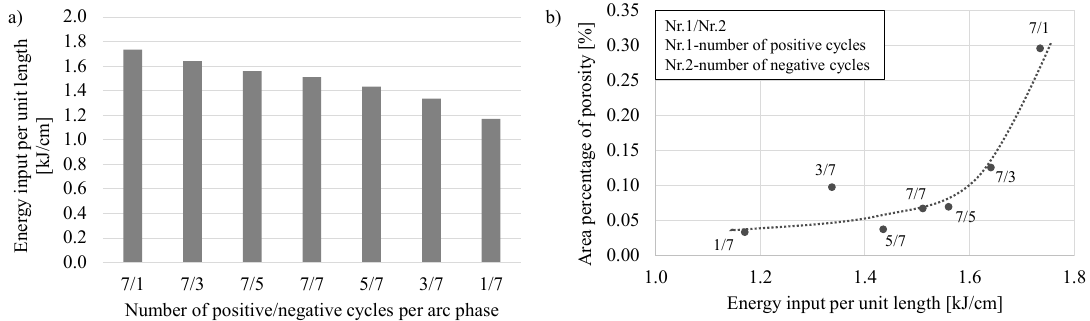
Figure 8. Correlation between ( a ) the energy input per unit length and ( b ) the porosity and the energy input per unit length (assigned with the number of positive and negative cycles per arc phase) at a welding speed of 0.6 m/min.